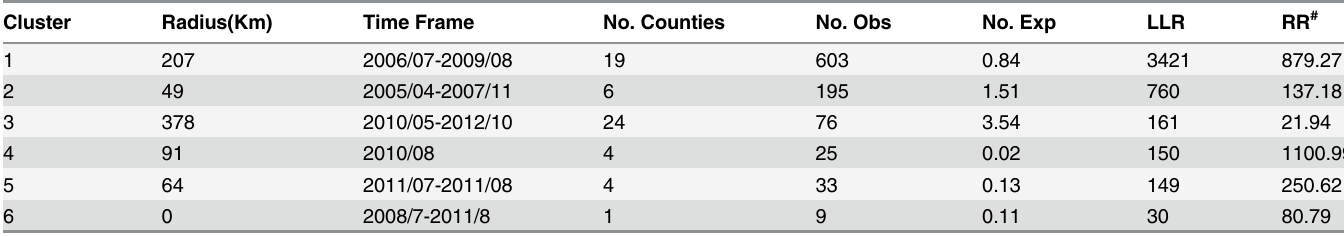
Table 1. Space-time clusters of human cutaneous anthrax in China, 2005 – 2012.